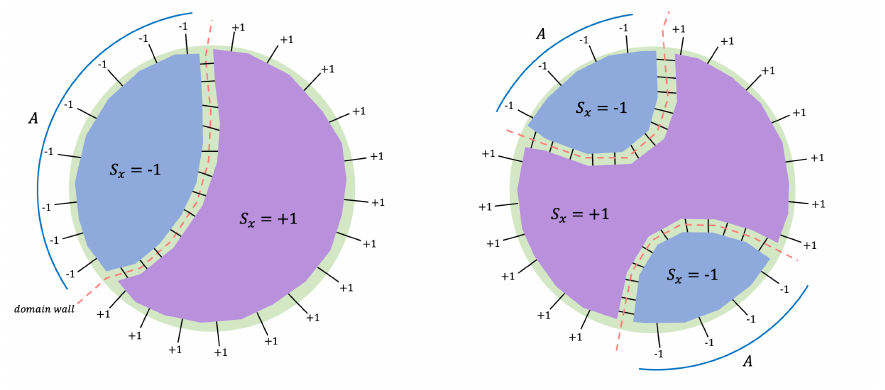
Figure 3 . Example of spin configurations used to calculate the entanglement entropy for connected boundary region (left) and disconnected region